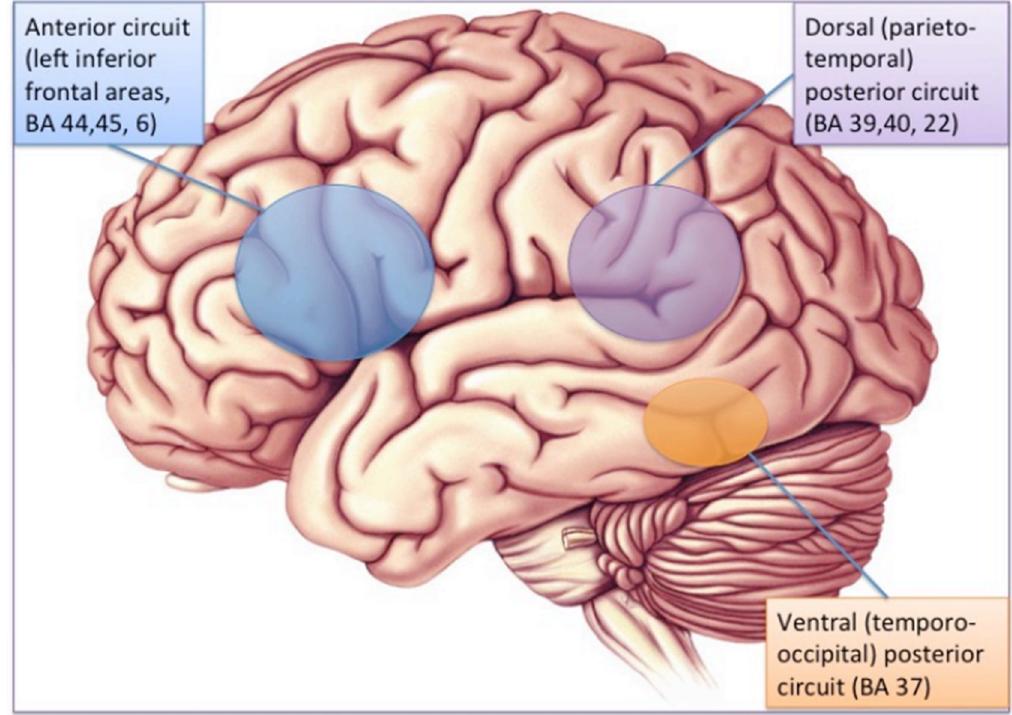
Figure 1. The brain reading network: left-hemisphere cortical regions showing consistent structural and functional abnormalities in phonological dyslexic adults and children [23].